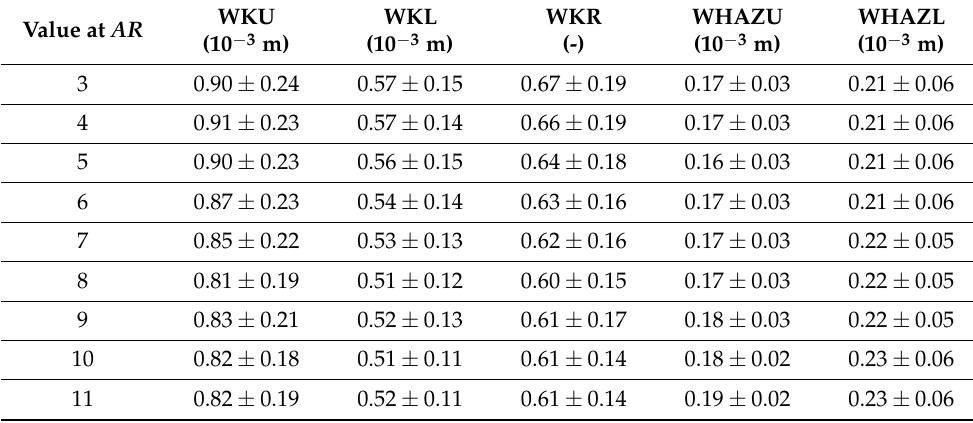
Table 3. Descriptive statistics of all the measured parameters vs. AR. Value at AR